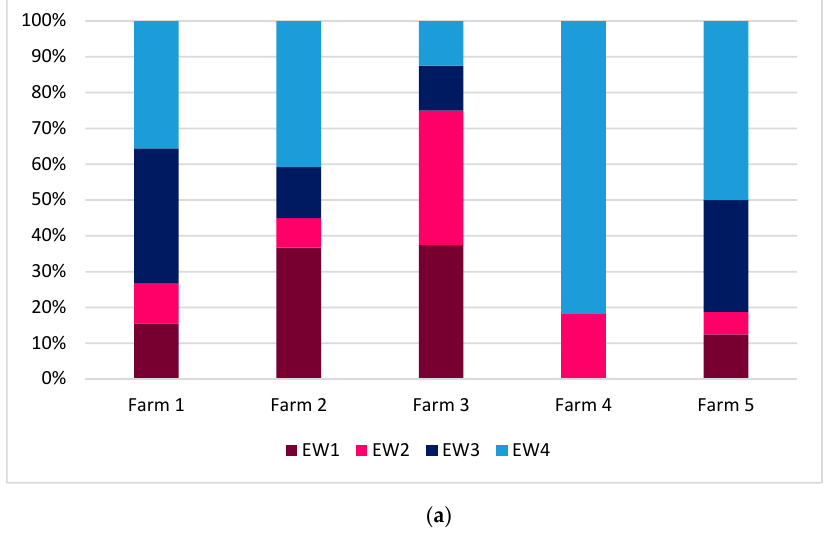
Figure 5. Percentage distribution of the four ear posture classes in each context (feeding, resting, pasture, ADF–avoidance distance test at the feeding rack).